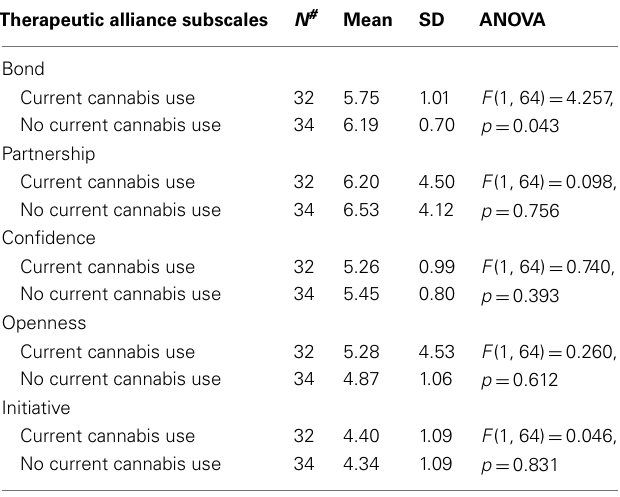
Table 6 | Clinician-rated therapeutic alliance (as measured by the Agnew-Davies Relationship Measure) for current versus non-current cannabis users*.